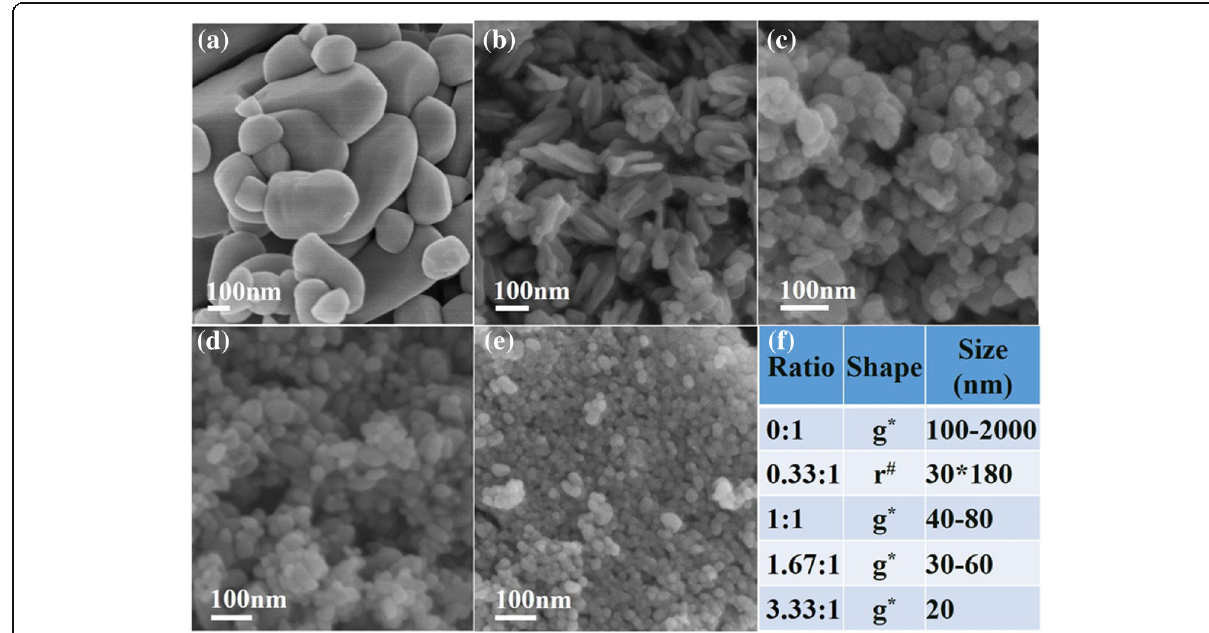
Fig. 1 SEM images of ZnO nanoparticles obtained from 65% ZnCl 2 aqueous solution under the different mole ratios of glycerol to Zn 2+ ( a , 0:1; b , 0.33:1; c , 1:1; d , 1.67:1; e , 3.33:1) and ( f ) the statistics table about the morphology and size of ZnO nanoparticles (g * : globular, r # :